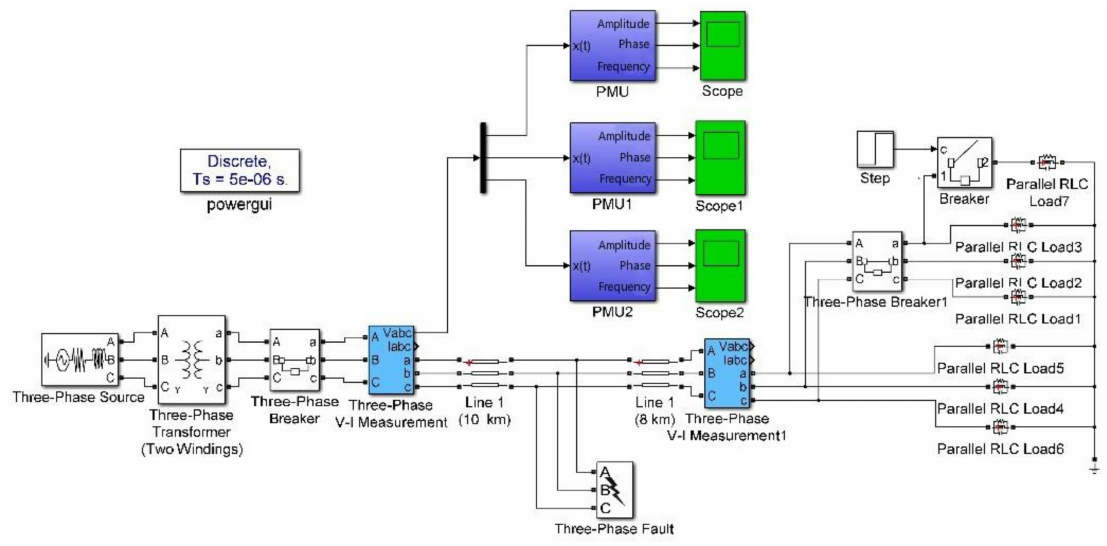
Figure 11. A 10 kV distribution network